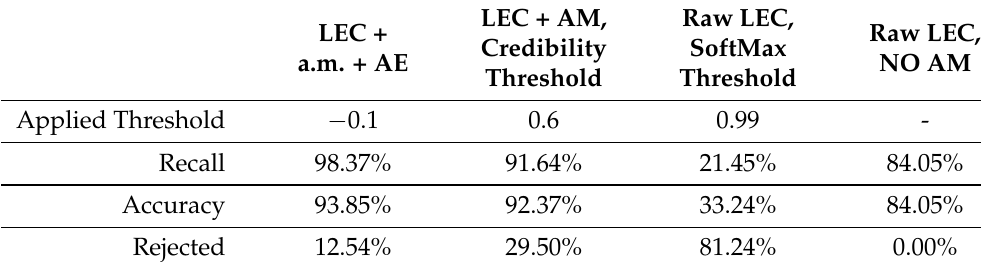
Table 3. Metrics with different assurance technologies.